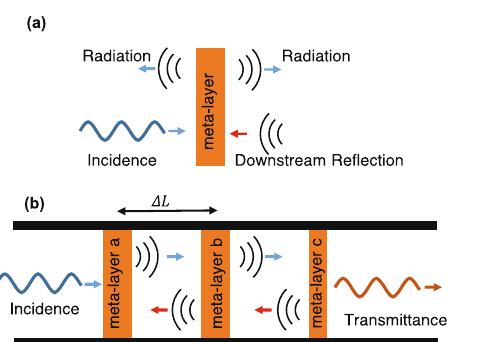
Fig. 6 Schematic diagram of multiple layers con fi guration for idle wave suppression. a Waves coupled to one layer. For each layer, the excitation consists of incident wave and downstream re fl ected waves, and its vibration radiates waves to both downstream and upstream. b Multiple meta-layers in the one-dimensional waveguide where fi xed time difference can be introduced between modulation signals of the same waveform to different meta-layers. Δ L is the distance between two